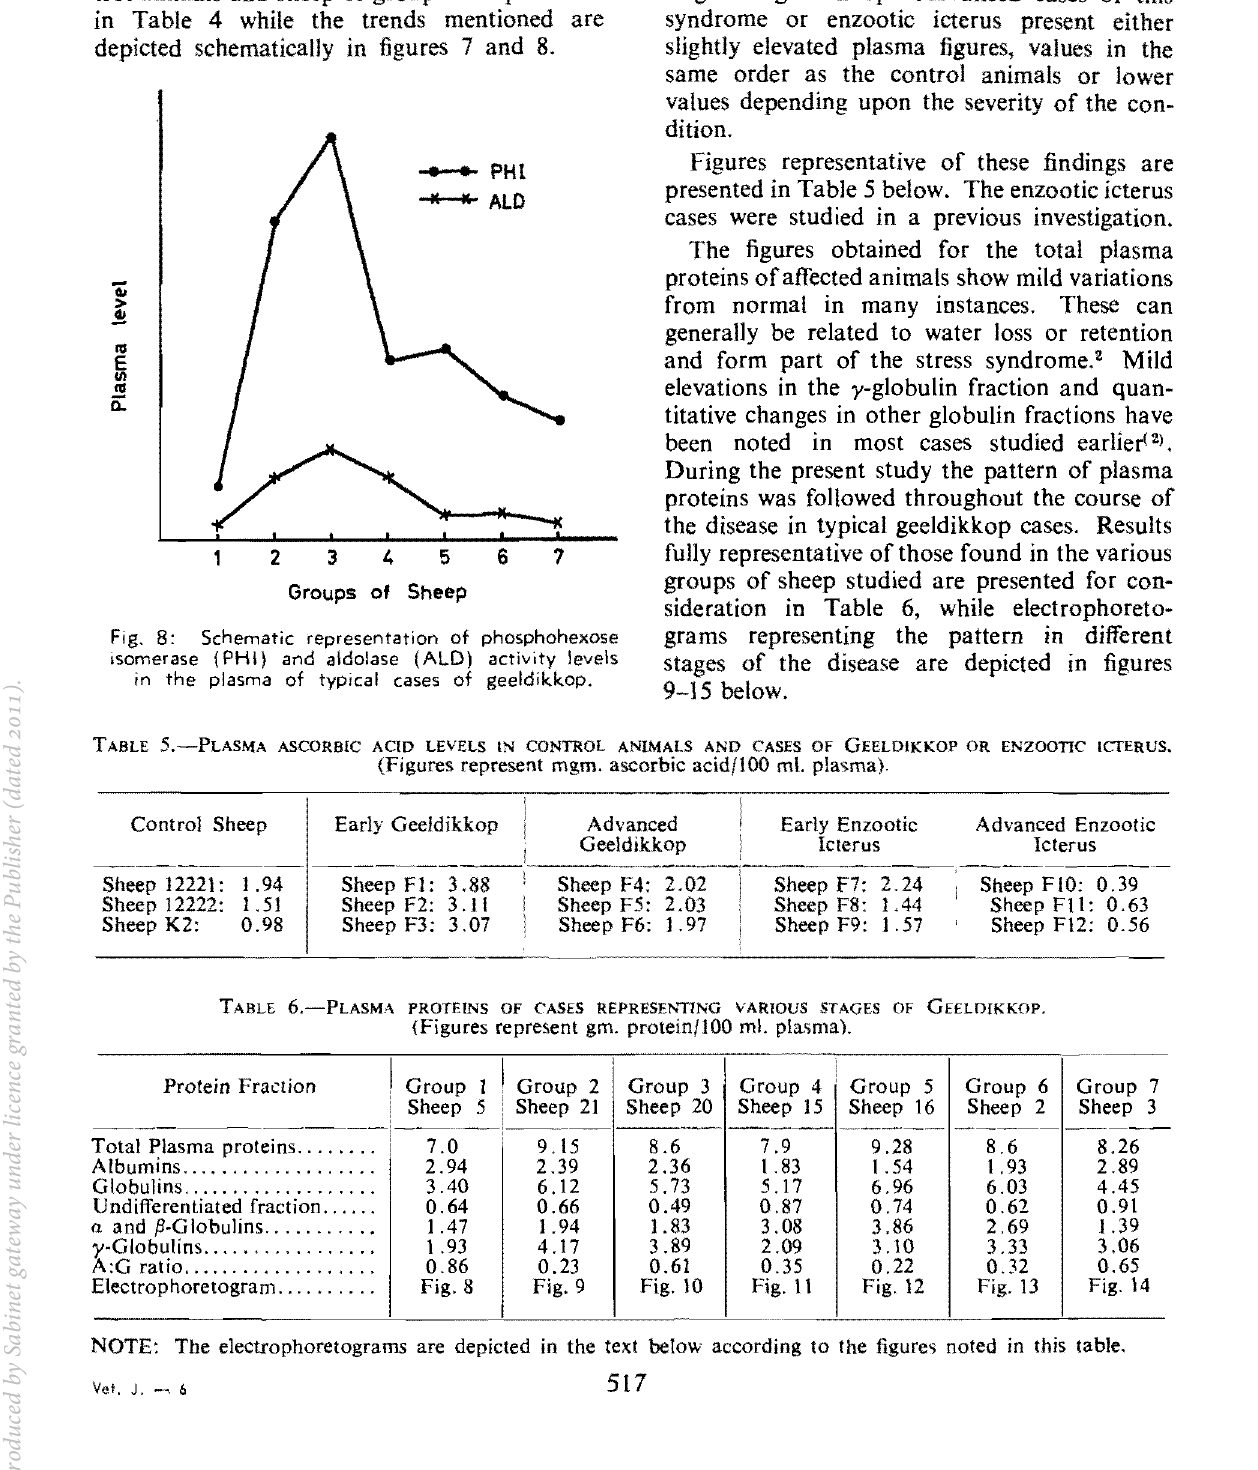
TABLE 6.-PLASMA PROTEINS OF CASES REPRESEl'.'TING VARIOUS STAGES OF GEELDIKKOP. (Figures represent gm. protein/tOO ml. plasma). Protein